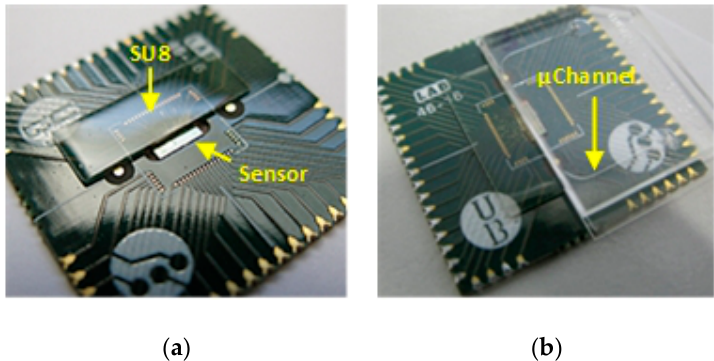
Figure 5 . ( a ) Fully encapsulated SPAD Sensor Array chip using SU8 to protect the wire bonds; ( b ) SU8 wire bonds protection as stop for the microfluidic chip.